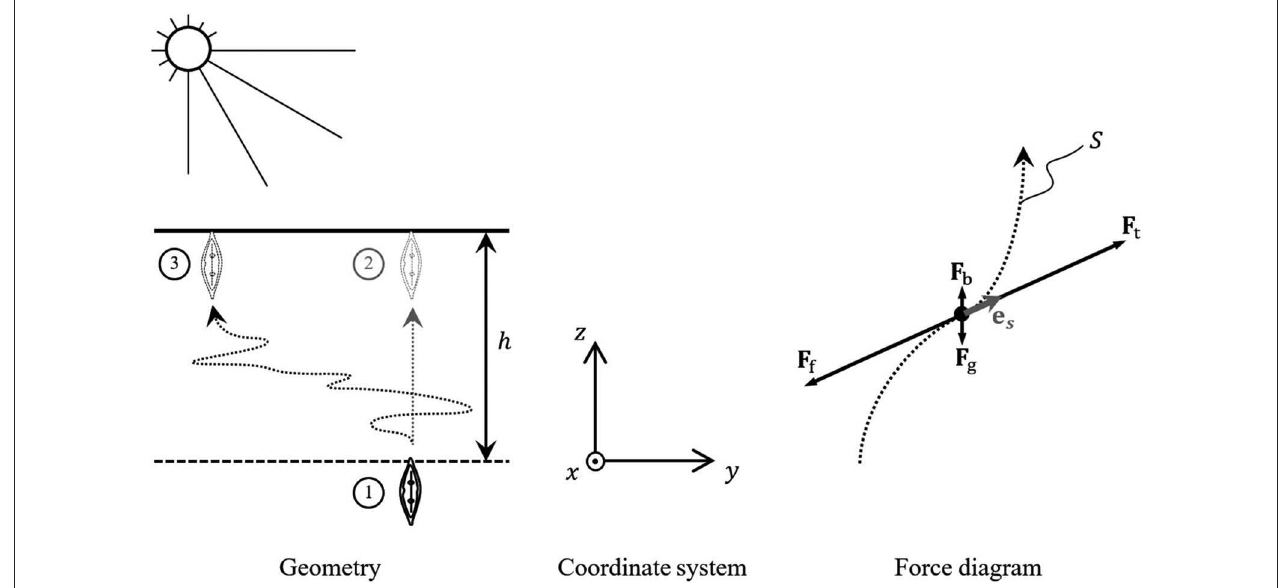
FIGURE 1 | Vertical migratory movements of a motile diatom rising to the surface through a photic sediment layer of depth h